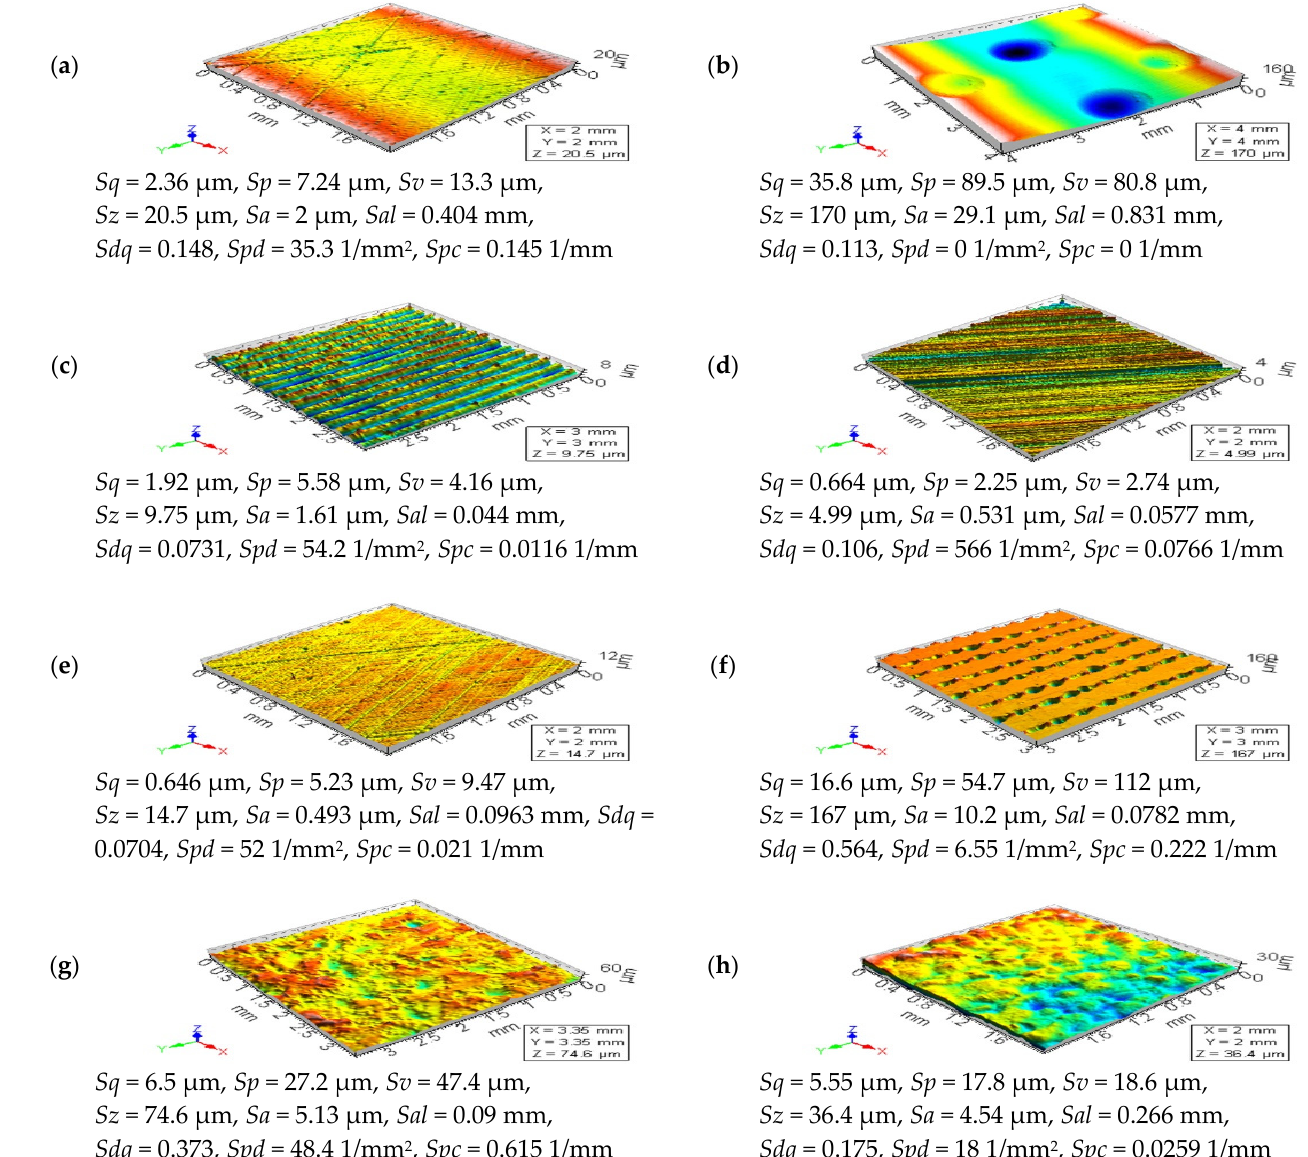
Figure 1. Examples of analyzed surfaces with selected surface topography parameters correspondingly, as follows: cylinder liner ( a ) with additionally burnished dimples ( b ), turned ( c ), ground ( d ), milled ( e ), laser-textured ( f ), composite ( g ), and ceramic ( h )